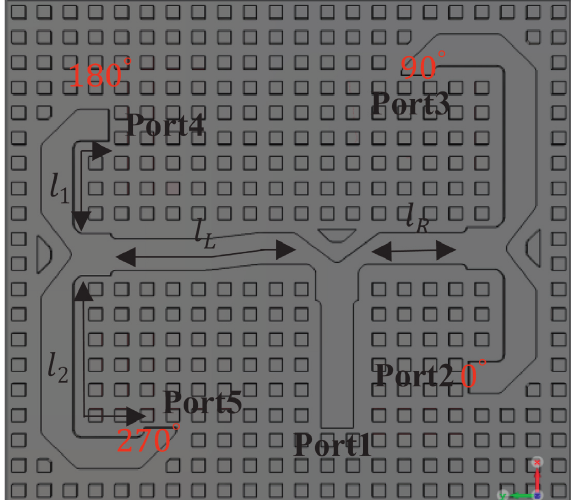
Figure 4: The geometry of the 4-way sequential-phase feeding network.